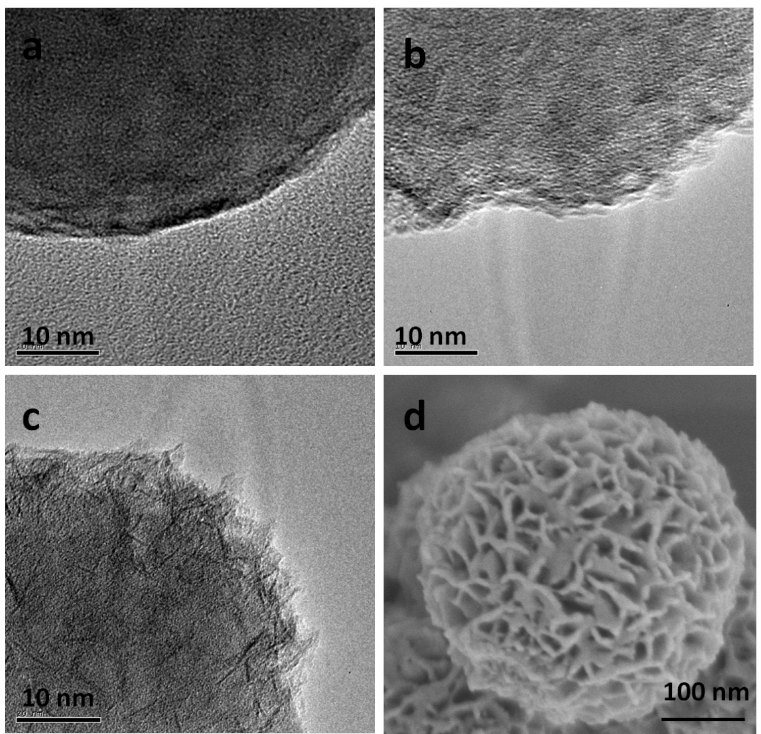
Figure 4. ( a ) HR-TEM image of sample at the beginning of reaction; ( b ) HR-TEM image of sample after 30 min of reaction; ( c ) HR-TEM image of sample after 90 min of reaction; ( d ) FE-SEM image of sample after 120 min of